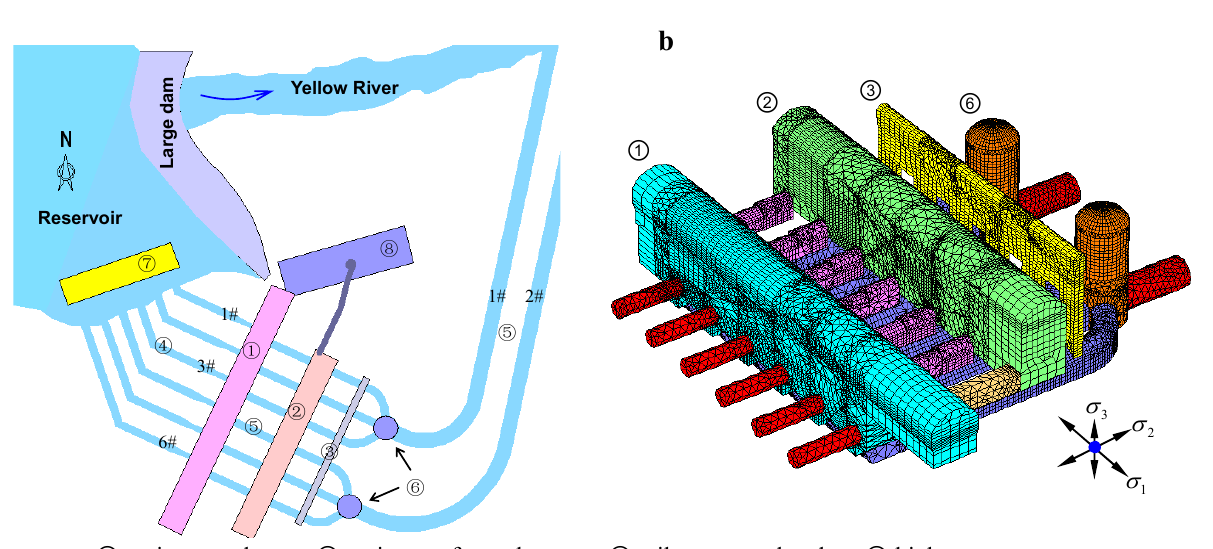
Figure 4. Underground cavern group of the Laxiwa hydropower station. ( a ) Layout of the main underground caverns; ( b ) Meshed 3D model of the